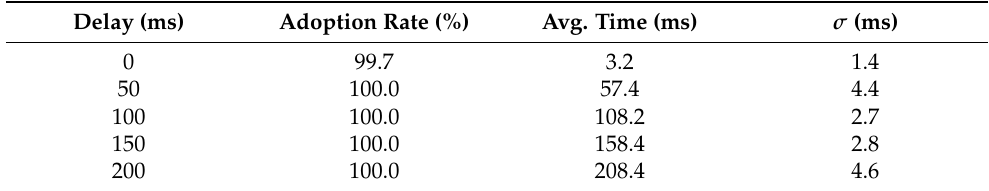
Table 1. HTTP/3 adoption rate and connection establishment time with external delay settings. (Happy Eyeballs).